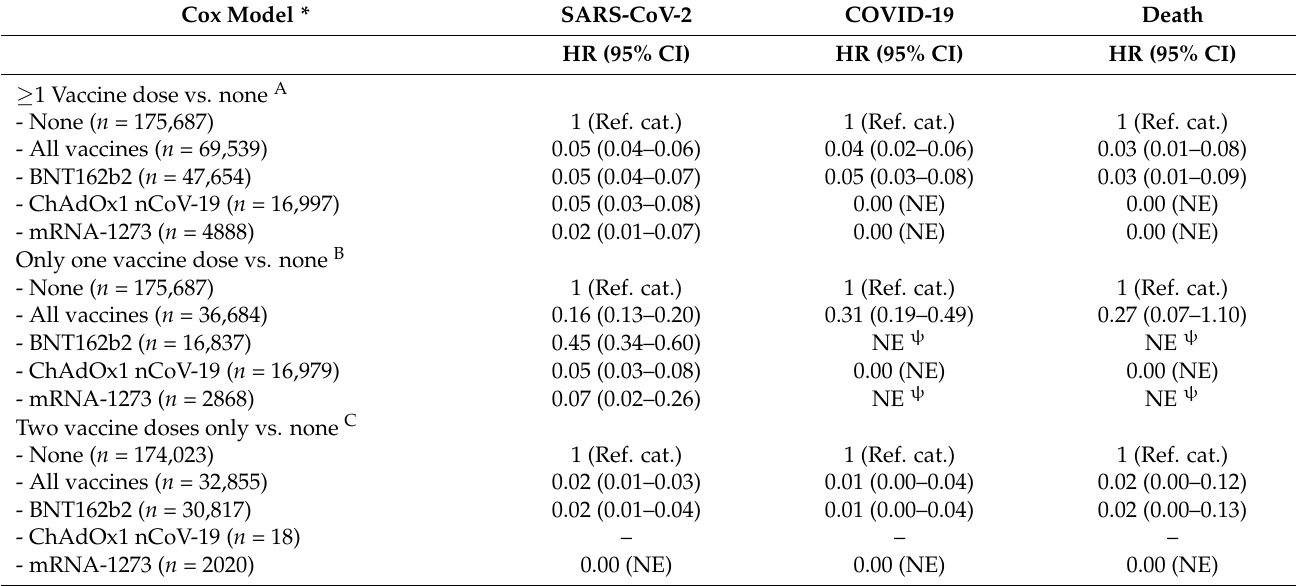
Table 2. Multivariate analysis of the effectiveness of COVID-19 vaccines.